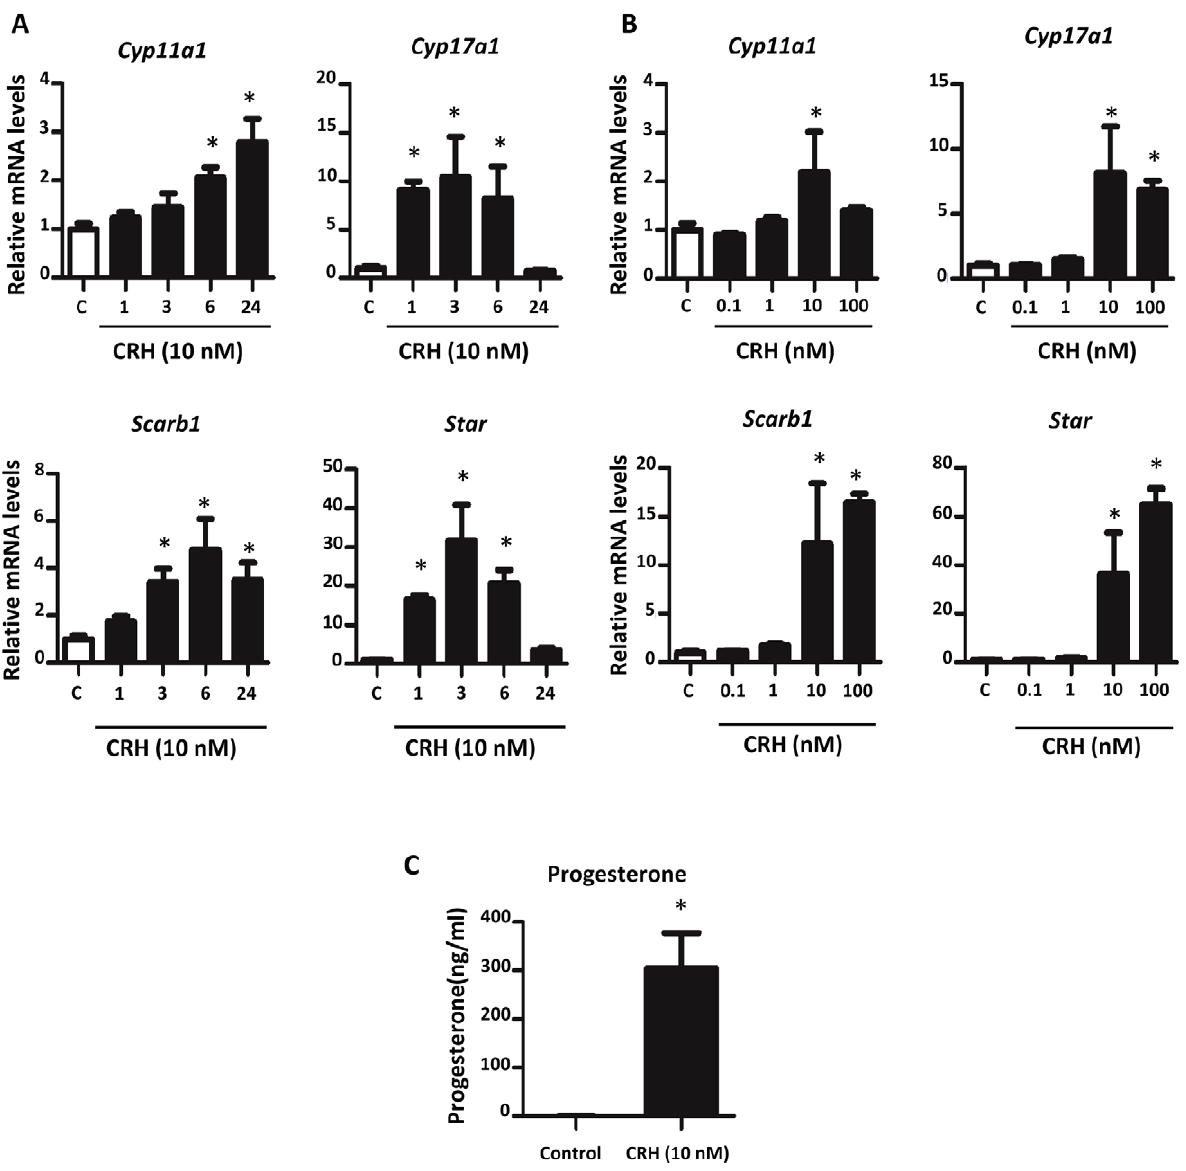
Figure 7. Effect of CRH on MA-10 cell steroidogenesis. A) CRH exposure of MA-10 cells increased steroidogenic gene expression at different time points. MA-10 cells were exposed to 10 nM CRH for 1, 3, 6 or 24 hours. Three to six replicates were analyzed at each time point. Taqman-based qRT-PCR was used to determine mRNA levels. Mean 6 SD are shown for all data. Asterisk indicates significance for p-value of , 0.05 when compared with controls. B) CRH concentration-response of MA-10 cell steroidogenic mRNA expression. MA-10 cells, five replicates/group, were exposed to varying concentrations of CRH for 6 hours. Taqman-based qRT-PCR was used to determine mRNA levels. Mean 6 SD shown for all data. Asterisk indicates significance for p-value of , 0.05 when compared with controls. C) CRH increased MA-10 cell progesterone secretion. Eight replicates/group were treated for 6 hours, and progesterone levels in media were quantified by radioimmunoassay. Mean 6 SD shown for all data. C: Control. Asterisk indicates significance of a p-value ,